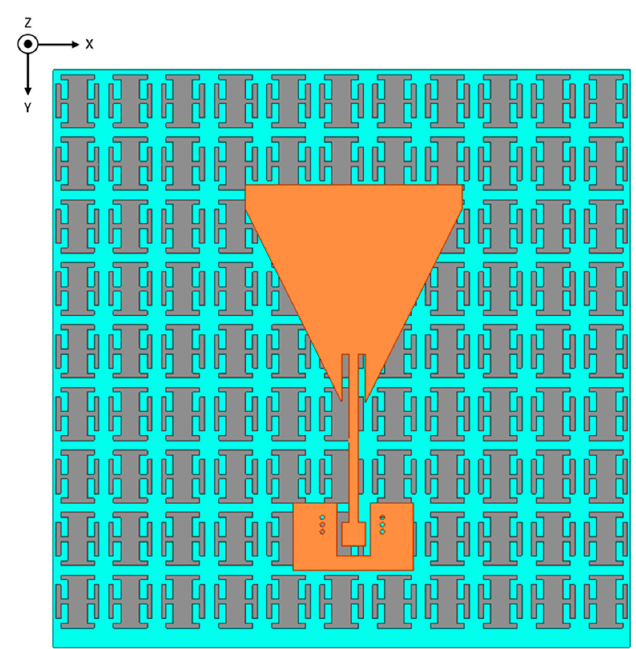
Figure 3. The geometry of the designed monopole patch antenna and M1 layer AMC.